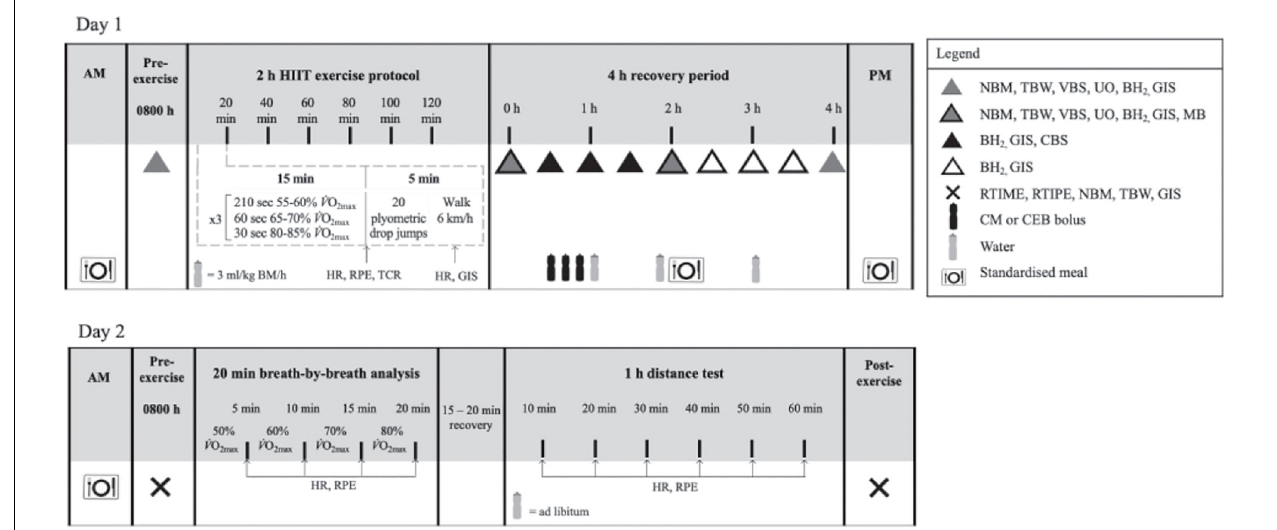
FIGURE 1 | Schematic illustration of the experimental design. NBM, nude body mass; TBW, total body water; VBS, venous blood sampling; UO, urine output and osmolality; BH 2 , breath hydrogen; GIS, gastrointestinal symptoms; HR, heart rate; TCR, thermal comfort rating; RPE, rating of perceived exertion; MB, muscle biopsy; CBS, capillary blood sampling; RTIME, readiness to invest mental effort; RTIPE, readiness to invest physical effort; RER, respiratory exchange ratio; CM, chocolate flavored dairy milk; CEB, carbohydrate-electrolyte beverage; BM, body mass.